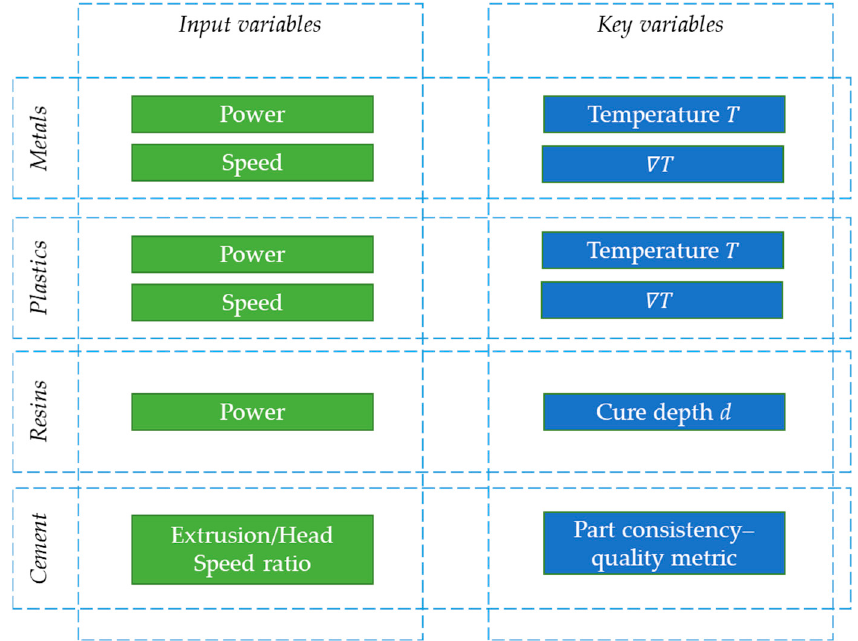
Figure 8. Process variables implicated in the complexity estimation.